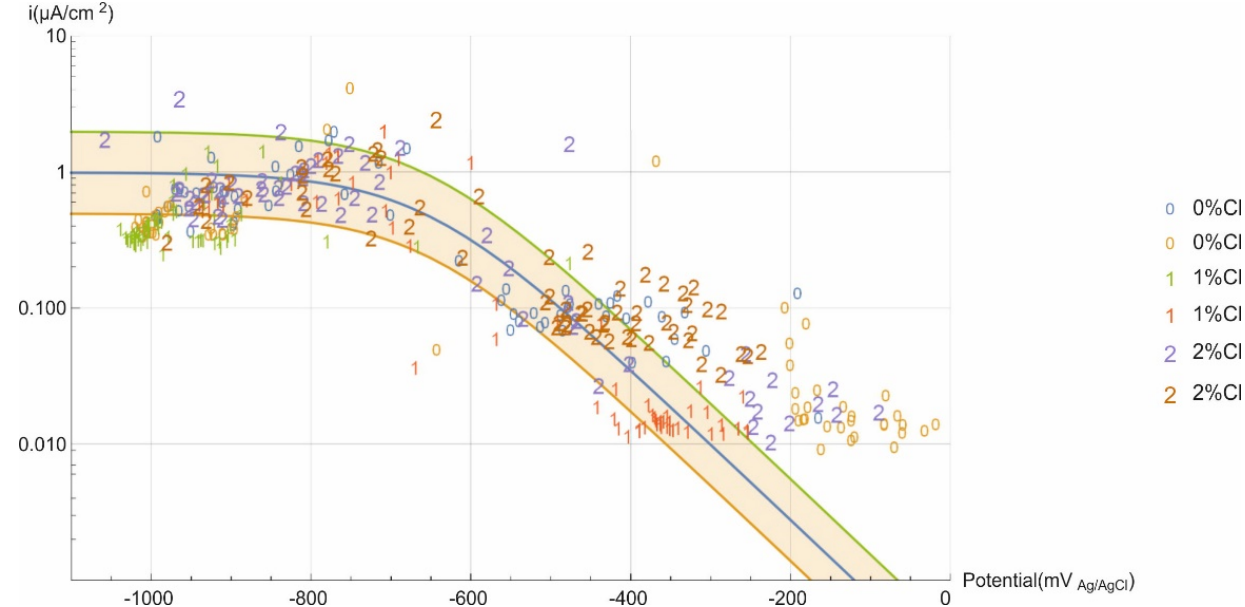
Figure 13. Evans diagram for the experimental data.